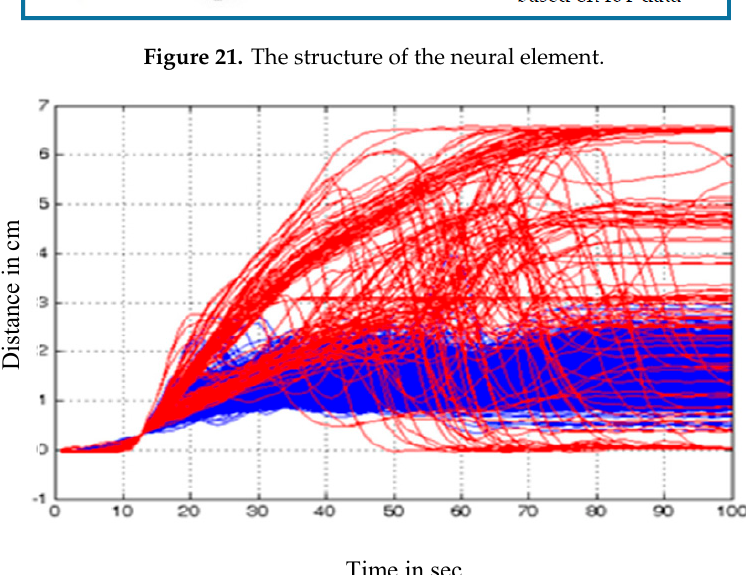
Figure 22. The time-distance eddy relationship. Processes 2020 , 8 , x FOR PEER REVIEW